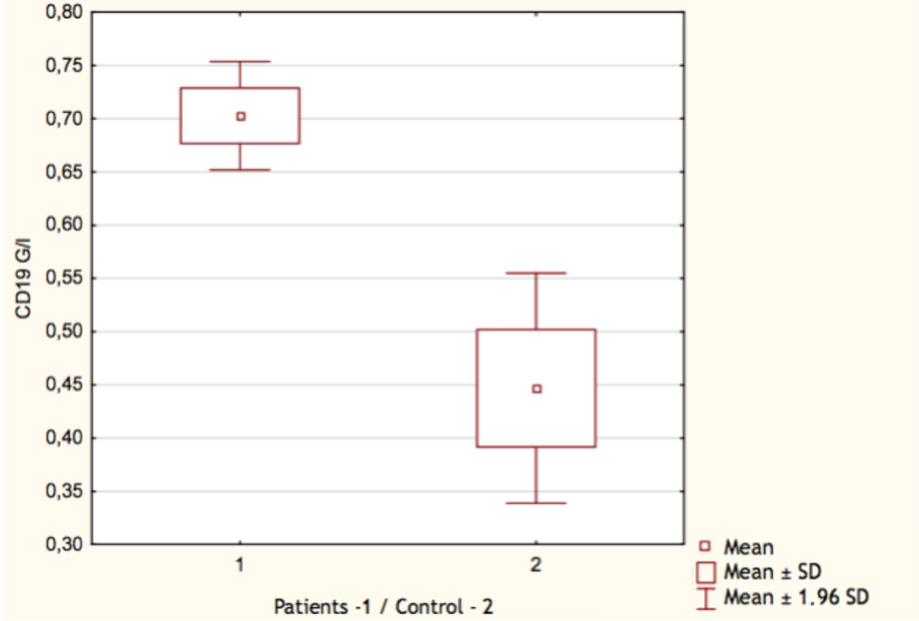
Figure 2. Count of CD19+ lymphocytes in patients (1) and control group (2).